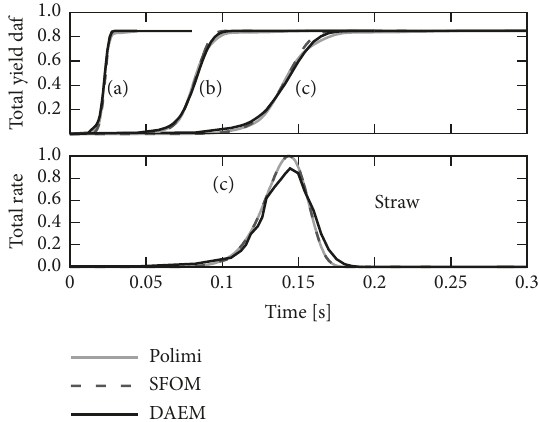
Figure 5: Biomass devolatilization. Top: total yield (daf); down: total rate (daf) normalised by the maximum value of the CPD rate. (a) From 300 to 1600 K in 0.04 s, (b) from 300 to 1500 K in 0.15 s, and (c) from 300 to 1400 K in 0.25